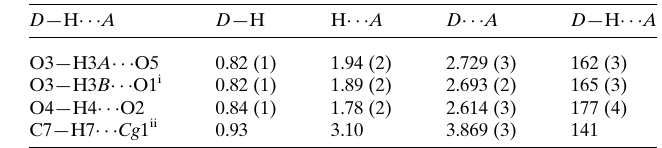
Table 1 Hydrogen-bond geometry (A˚ , (cid:4) ). Cg 1 is the centroid of the S1/C4–C7 ring.